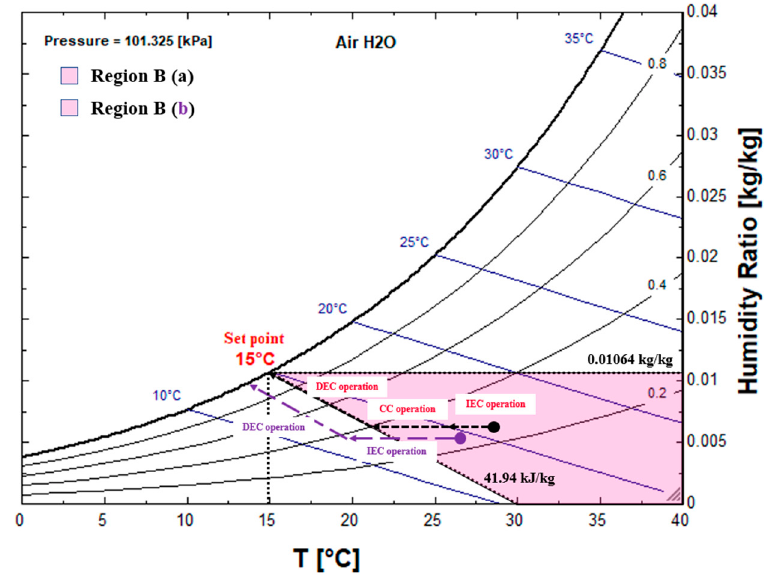
Figure 6. The two operating mode in IDECOAS region B.